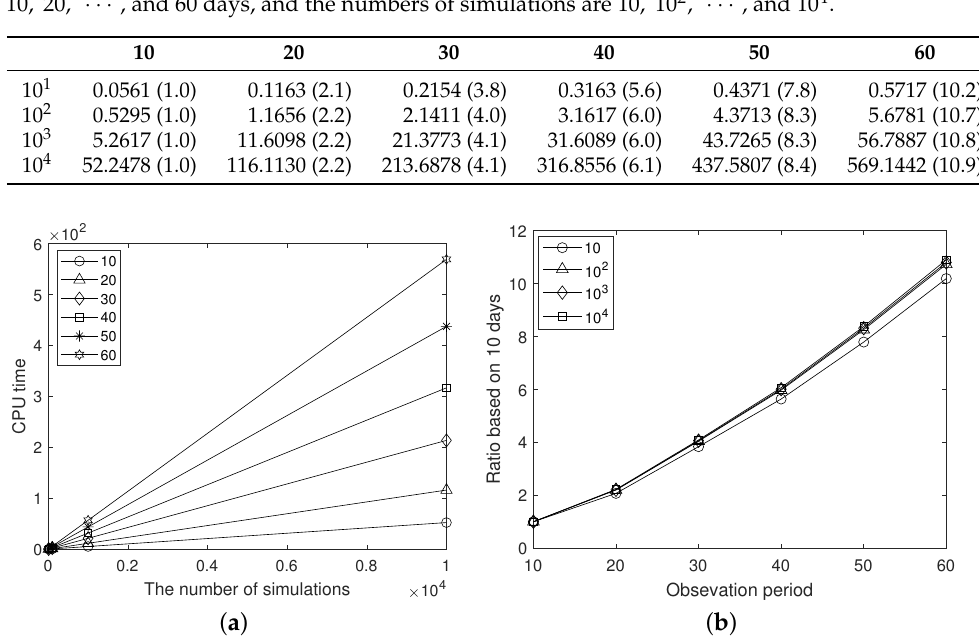
Table 3. CPU times (in seconds) for the presented algorithm with the observation periods are 10, 20, · · · , and 60 days, and the numbers of simulations are 10, 10 2 , · · · , and 10 4 .